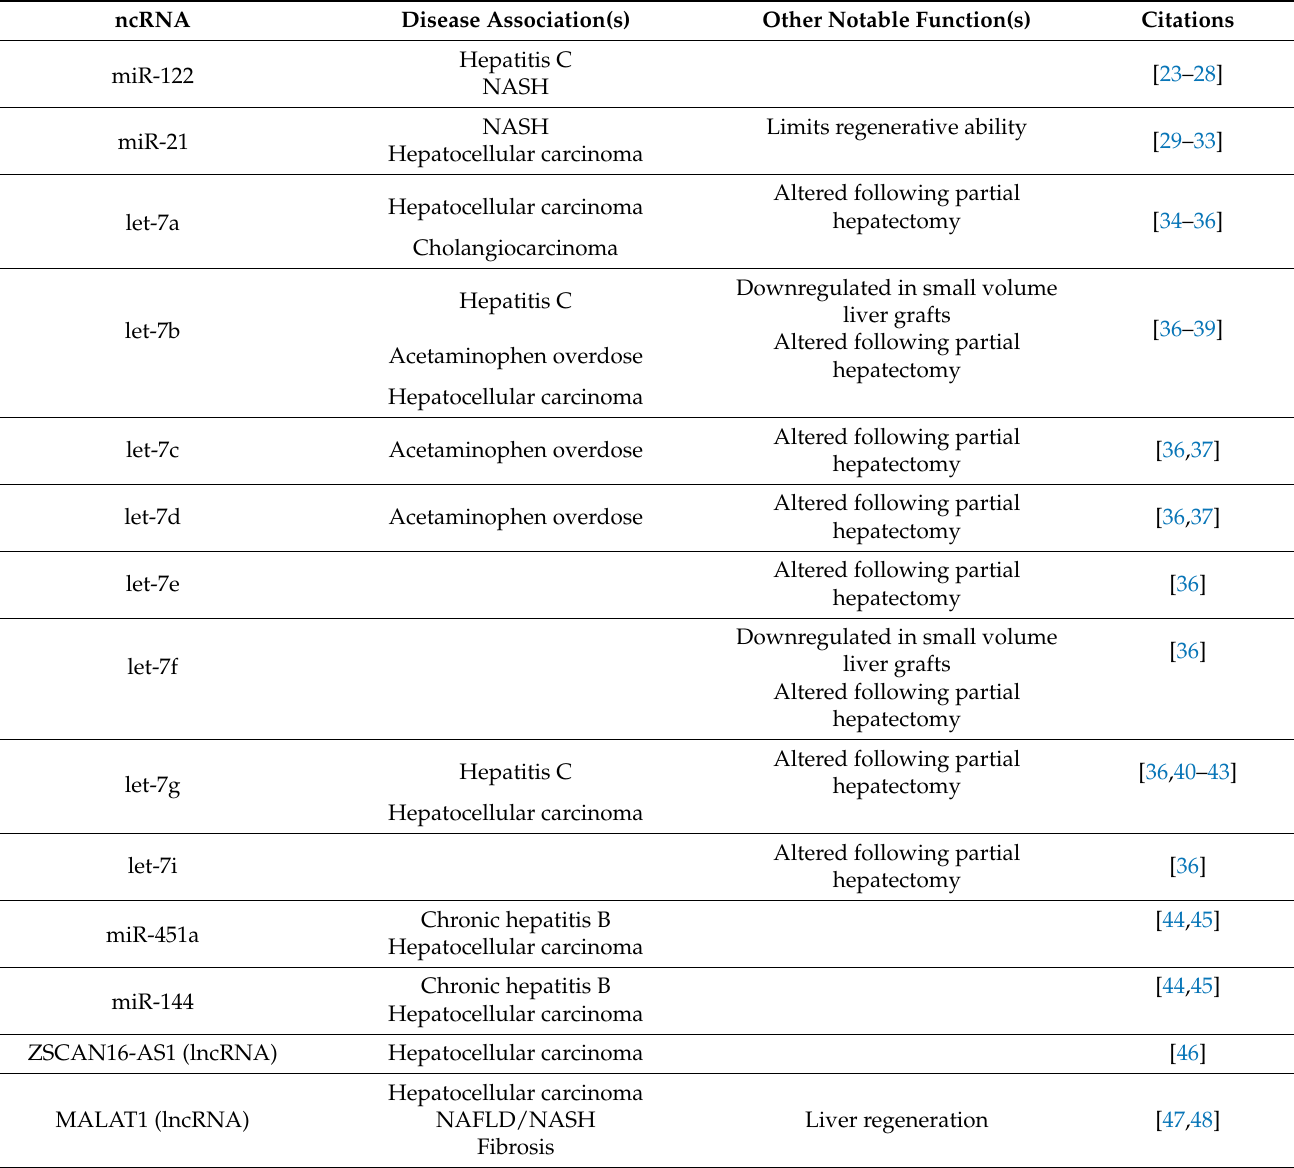
Table 1. Summary of ncRNA-associated pathologies and functions detailed in the main